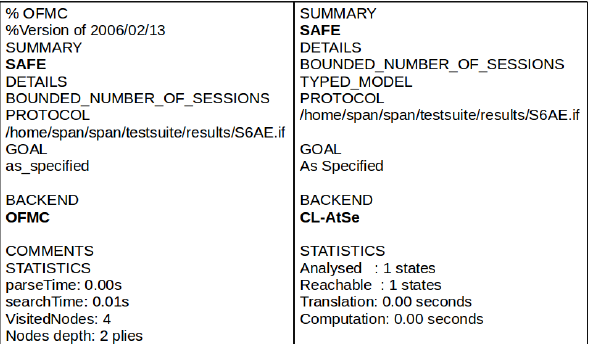
Figure 5. AVISPA OFMC and CL-AtSe back-end simulation results.